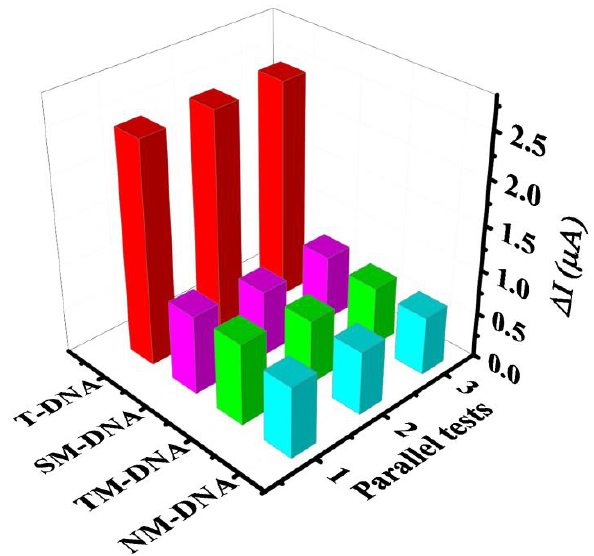
Figure 8. Selectivity of the developed biosensor for T-DNA (500 nM), SM-DNA (500 nM), TM-DNA